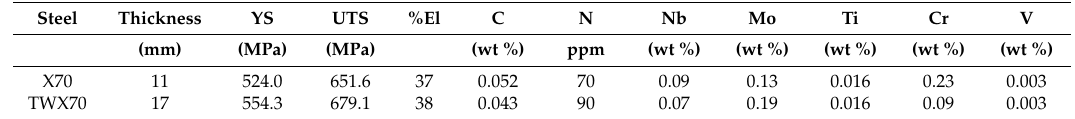
Table 1. Composition of X70 and TWX70